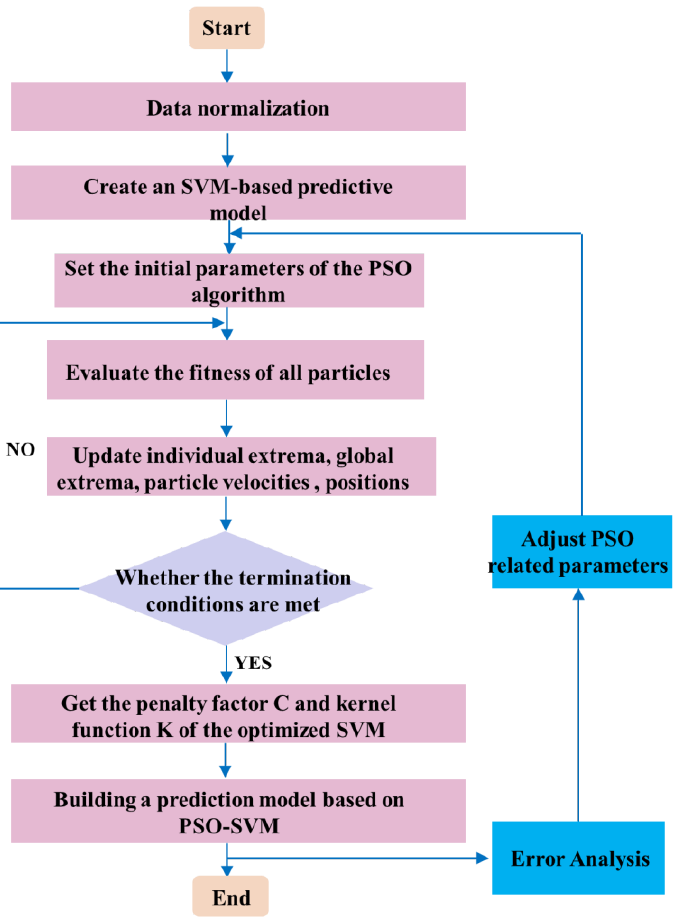
Figure 8. PSO-SVM algorithm flow chart.